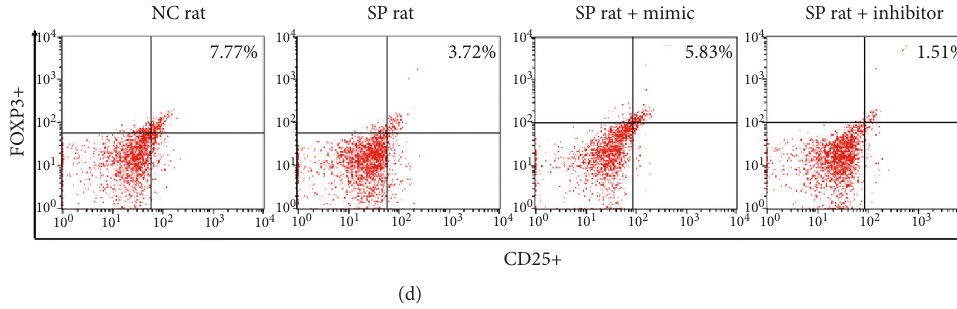
Figure 5: The ratios of Th17 and Treg cells in peripheral blood were changed after transfection of miR-21 activator or inhibitor into lymphocytes of septic rats. ((a) and (c)) The ratios of Th17 cells in peripheral blood in eight-paired NC rat group, SP rat group, SP rat +miR21 mimic group, and SP rat +miR21 inhibitor group were determined by flow cytometry [ t value (NC versus SP) � 18.445, p < 0.01; t value (miR-21 mimic versus SP) � 6.362, p < 0.01; t value (miR-21 inhibitor versus SP) � 2.477, p < 0.05]. ((b) and (d)) The ratios of Treg cells in peripheral blood in eight-paired NC rat group, SP rat group, SP rat +miR21 mimic group, and SP rat +miR21 inhibitor group were determined by flow cytometry [ t value (NC versus SP) � 9.836, p < 0.01; t value (miR-21 mimic versus SP) � 5.991, p < 0.01; t value (miR-21 inhibitor versus SP) � 5.180, p < 0.01]. NC group: normal control group; SP group: sepsis group; SP rat +miR21 mimic group: sepsis group with miR-21 activator transfected into lymphocytes; SP rat +miR21 inhibitor group: sepsis group with miR-21 inhibitor transfected into lymphocytes. ∗∗ p <